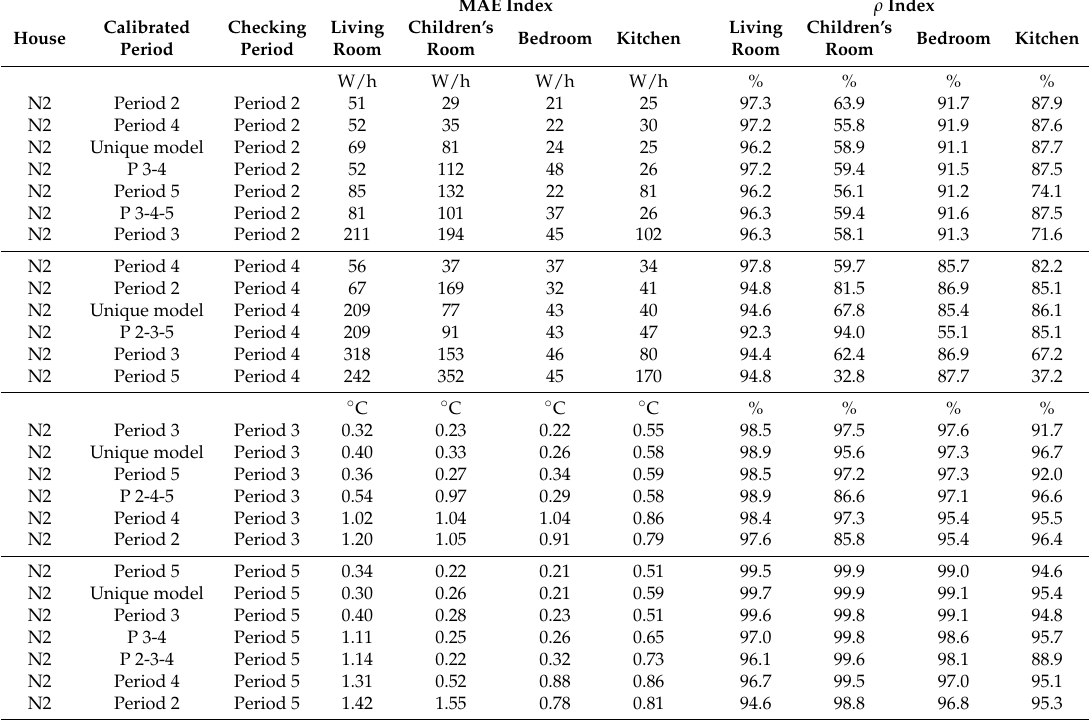
Table 4. Results of the N2 house models in the checking